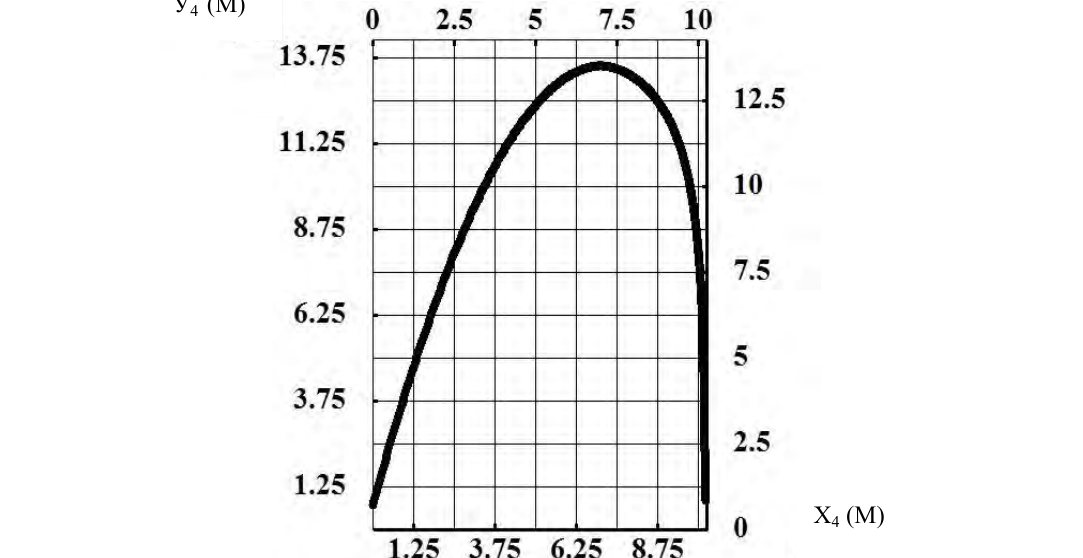
FDig.5. Graph dependence of parameters of ribbon flight for time t=4.5sec.; VС 0 =17.3m/sec; α C0 =74 0 ; h Cо =0.75m.; m= 0.1kg. For time of flight t=4.5sec. and received distance of ribbon flight Х 4 =10.5 m. sportswoman fulfills the following elements: throw of ribbon, three forward rolls around frontal axis and catching of ribbon with hands in last roll.